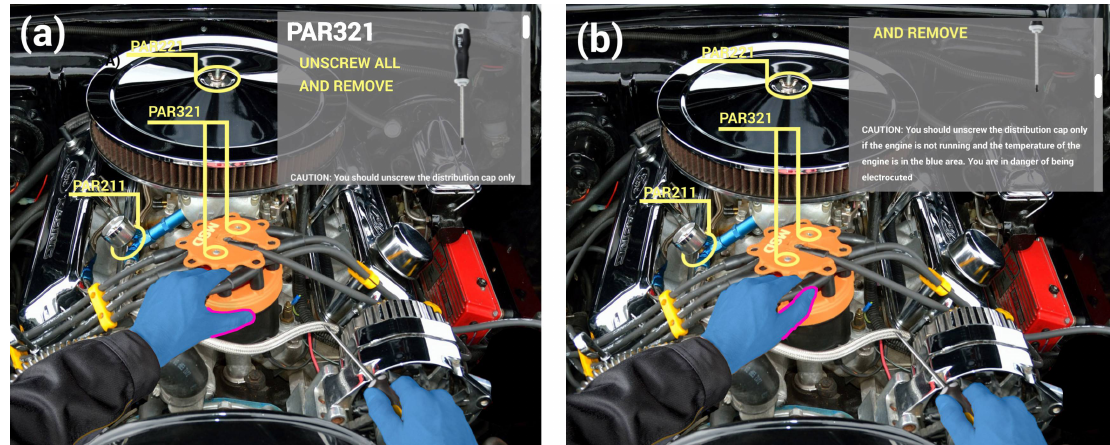
Figure 1. Application scenario illustrating our envisioned interactions. A mechanic who is following AR instructions visible though a head mounted display ( a ) can swipe on the nearby cable to ( b ) scroll down the instructions